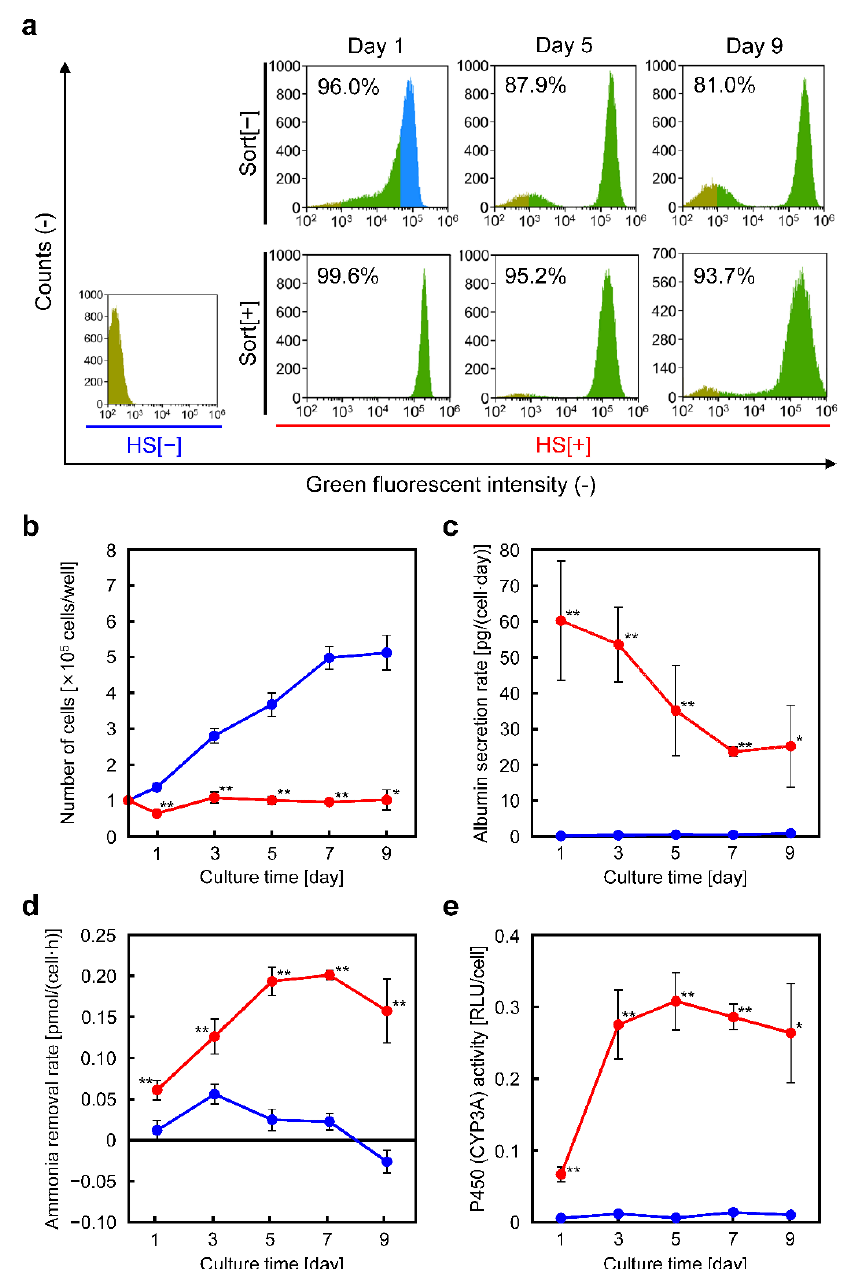
Figure 3. EGFP-based cell sorting and liver function analyses of heat-treated HepG2/8F_HS cells in monolayer culture: ( a ) EGFP flowcytometry of heat-treated HepG2/8F_HS cells with (Sort[+]) or without (Sort[ − ]) sorting during culture. EGFP-negative (yellow area) and positive (blue/green area) cell fractions are shown. The percentages of EGFP-positive cells are indicated in the histograms. The EGFP-positive fraction (blue area) was collected by cell sorting. ( b – e ) Liver function analyses of the EGFP-positive fraction of heat-treated HepG2/8F_HS cells. The number of cells ( b ), albumin secretion rate ( c ), ammonia removal rate ( d ), and cytochrome P450 (CYP3A4) activity ( e ) were measured. HS[−], blue symbols; HS[+], red symbols. Data are presented as means ± standard deviations ( n = 3); * p < 0.05, ** p < 0.01 vs. HS[−].